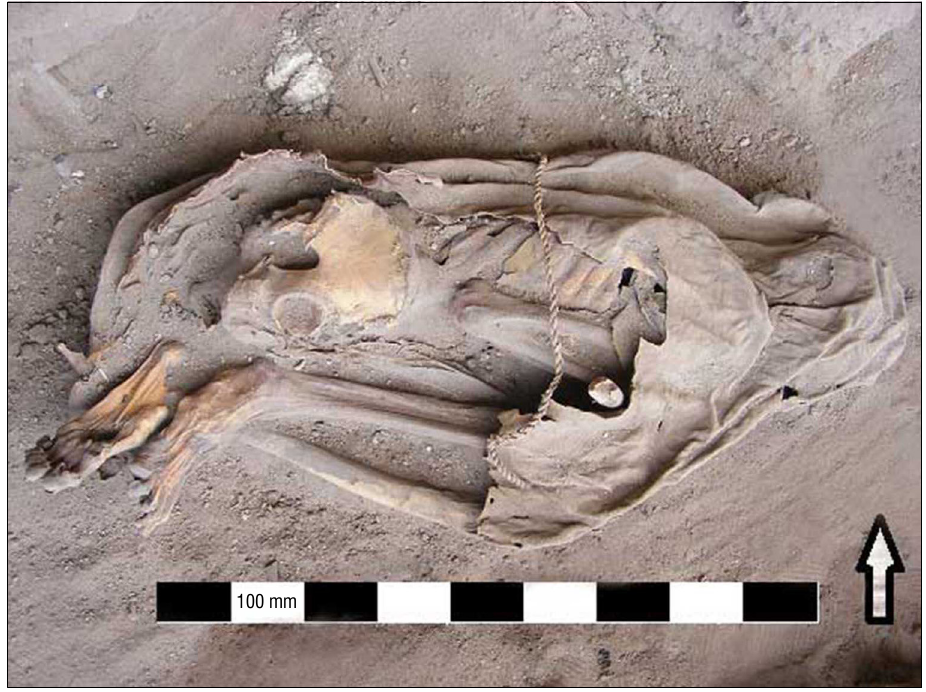
Figure 1: The intact mummy, covered with animal skin, discovered in the Tuli region of